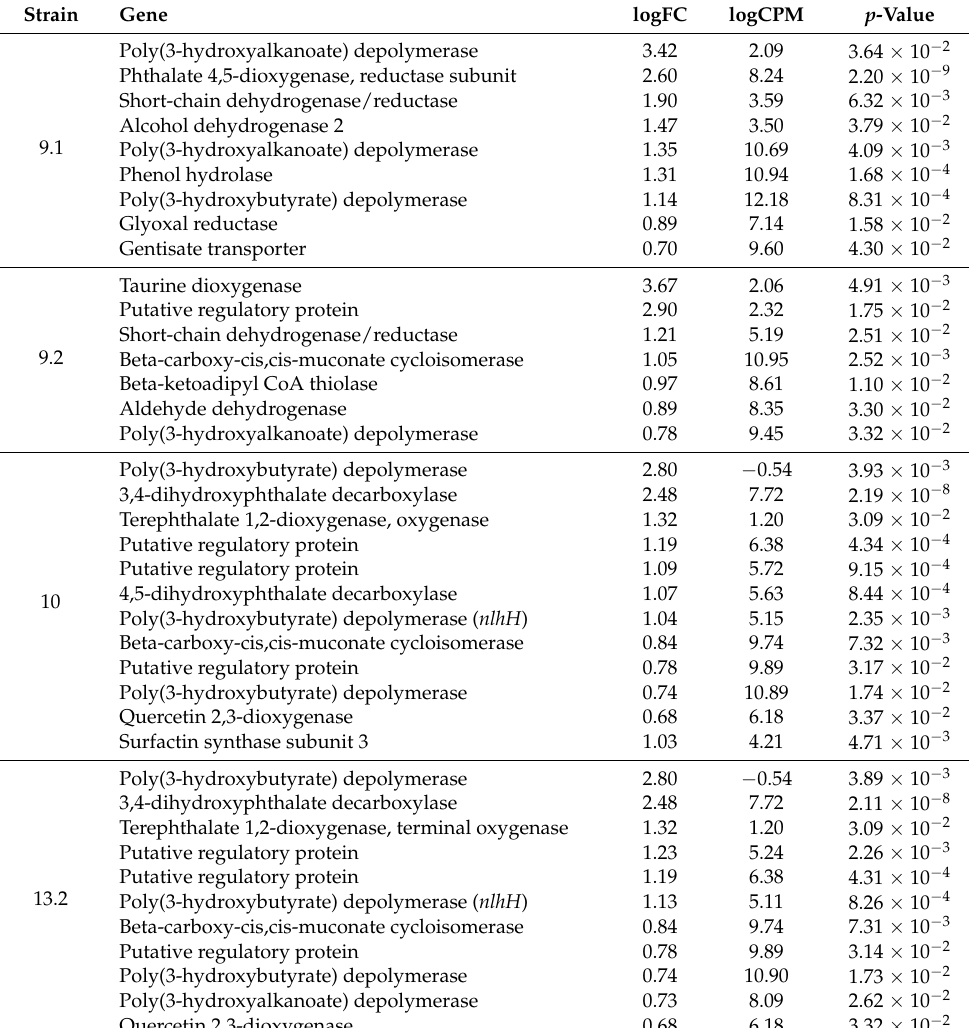
Table 4. Differential expression of upregulated genes within the individual strains that may be involved in PET